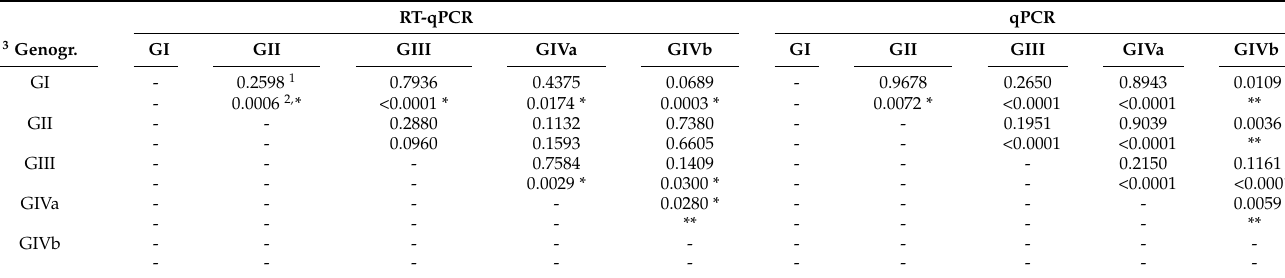
Table 3. Comparison of the quantification curves among